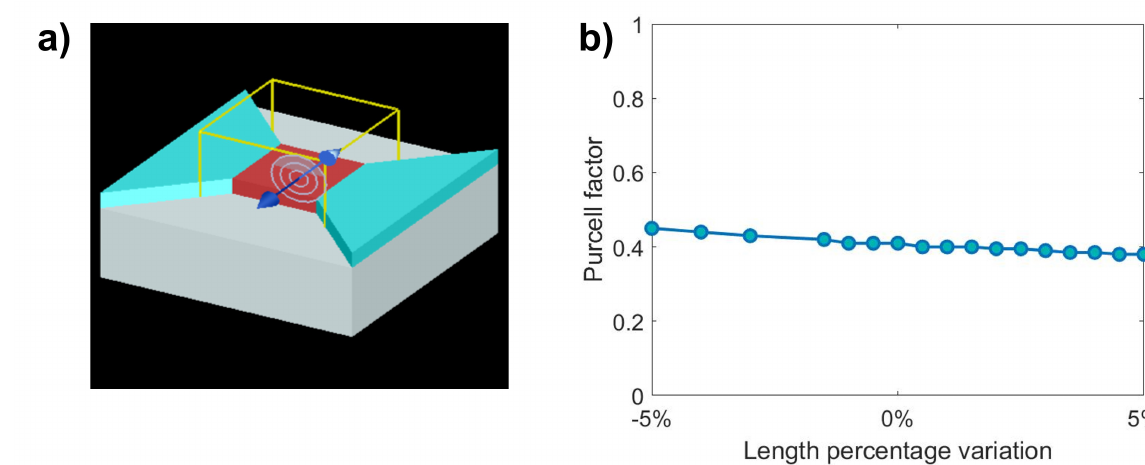
Figure 2. ( a ) Layout of the device simulated with FDTD. In red, the optically active part of the device is represented. This is simulated as a 1 µm × 1 µm undoped silicon square with dipole sources in it. The silicon oxide layer is the grey box and the contacts (in blue) are modelled as doped silicon regions. The blue arrow indicates the orientation of the dipole source whereas the grey concentric lines are the dipole radiation pattern. ( b ) Modification of the Purcell factor considering a variation of the lateral size of the optically active